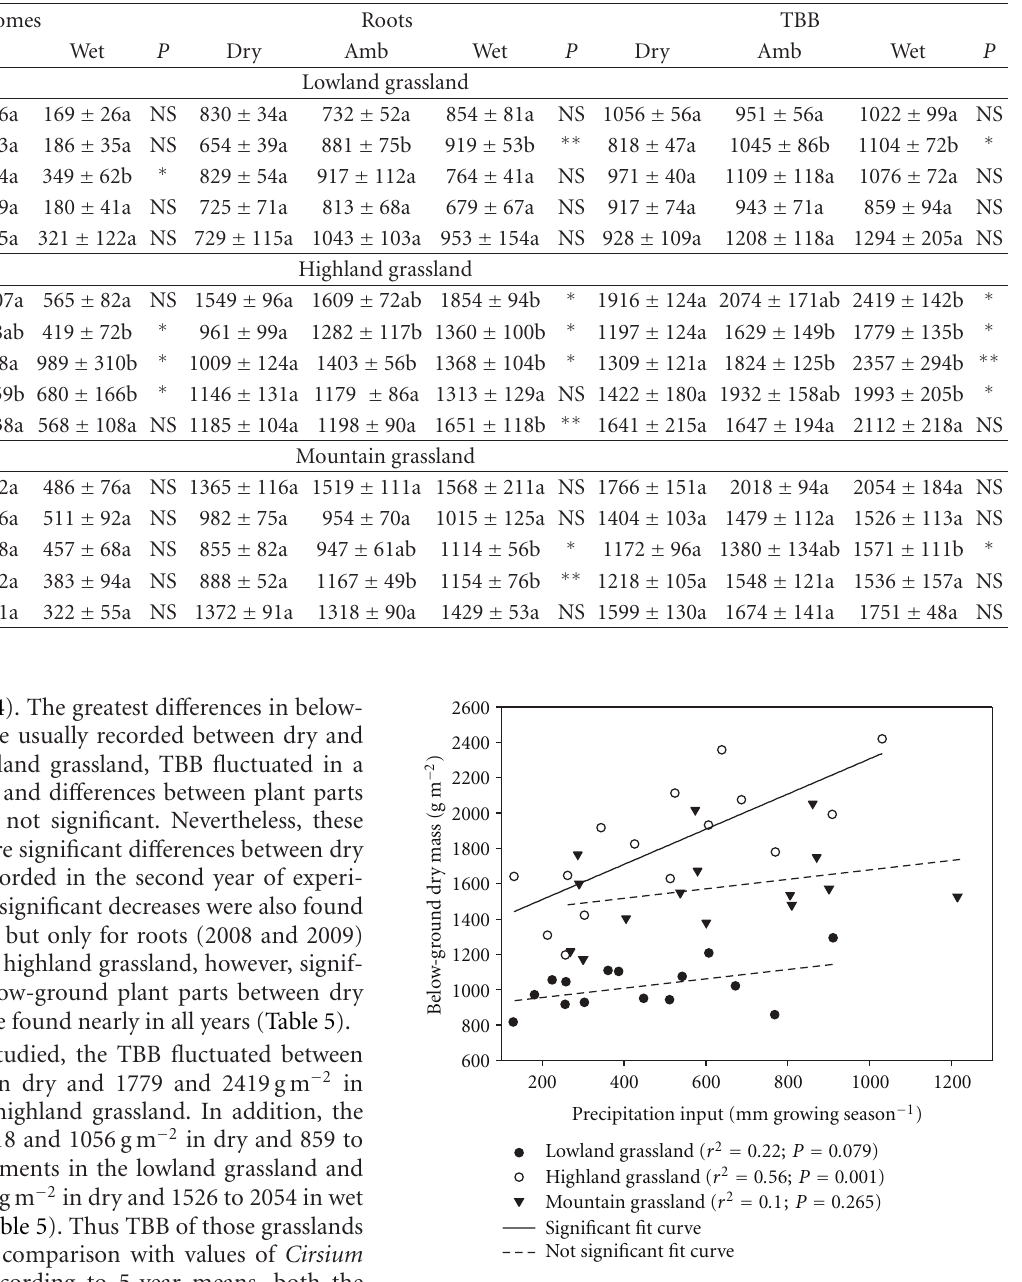
Figure 4: Relationship between the amount of total below-ground plant dry mass and precipitation input along the experimental precipitation gradient. Each point indicates annual